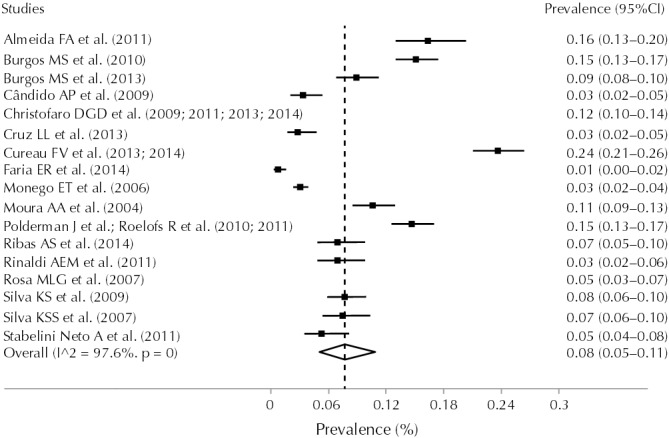
Prevalence of hypertension in Brazilian adolescents.